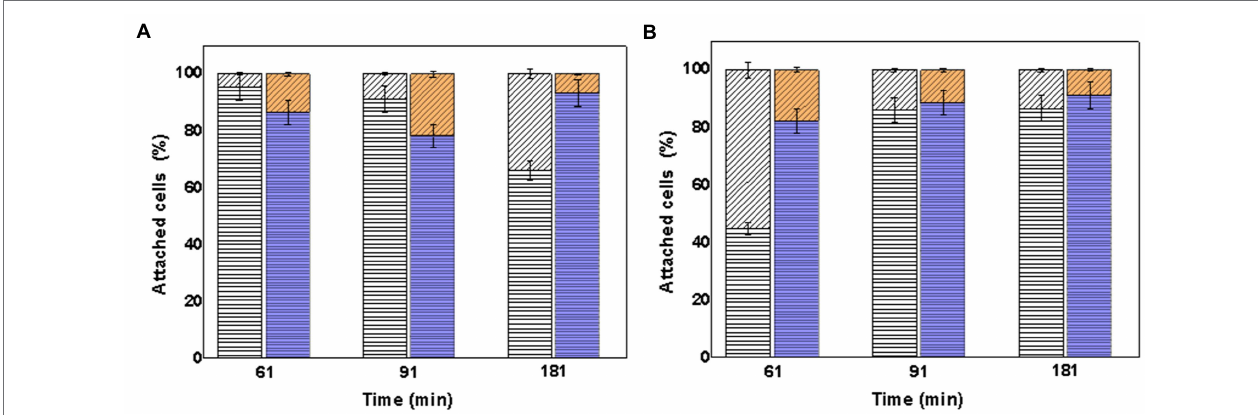
FIGURE 8 | Attachment percentage of the species At. thiooxidans DSM 14887 T and L. ferrooxidans DSM 2705 T on the surface of the mineral particles determined in the time. (A) Using L. ferrooxidans DSM 2705 T as a pre-colonizer. (B) Using At. thiooxidans DSM 2705 T as a pre-colonizer. Measurements at 61, 91, and 181 min from the inoculation of the first species. At. thiooxidans DSM 14887 T (diagonal lines) and L. ferrooxidans DSM 2705 T (horizontal lines). White Bars represent the control. Color Bars represent consortia adapted to D-galactose. The data correspond to the mean values of triplicates ± SD ( n =